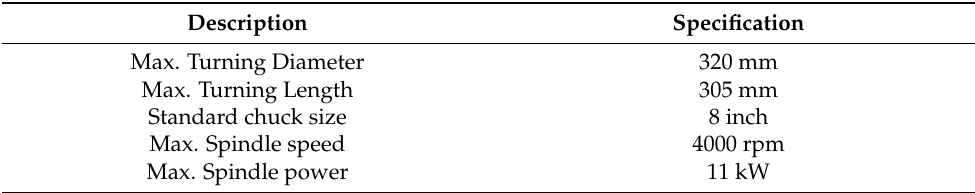
Table 1. Specifications of the CNC lathe used in the experiment.